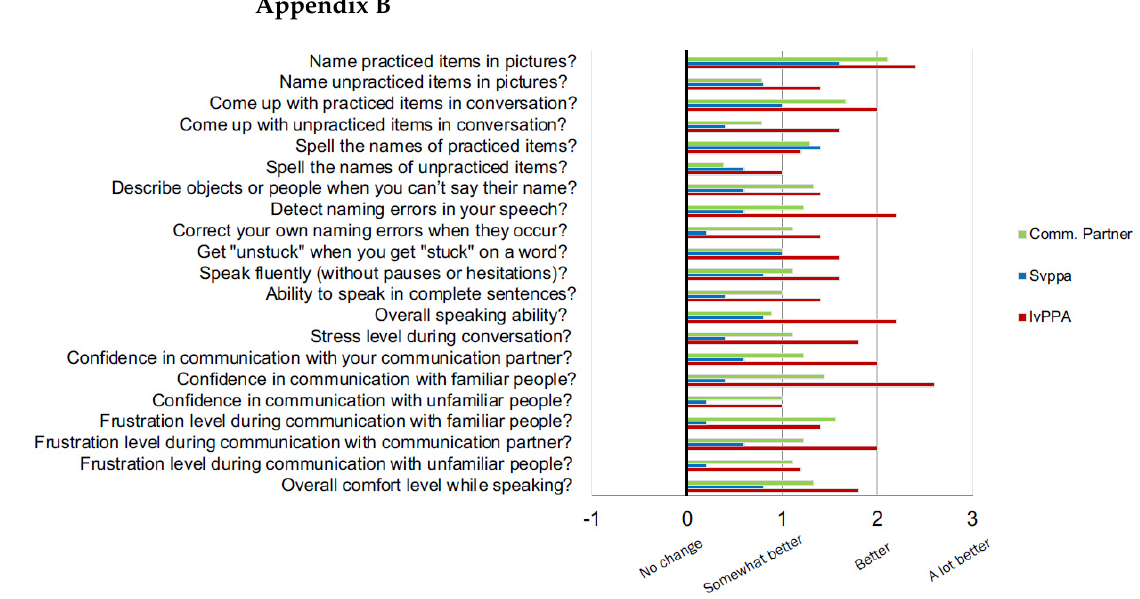
Figure A2. Survey Responses: “Compared to pre-treatment how would you rate your ability